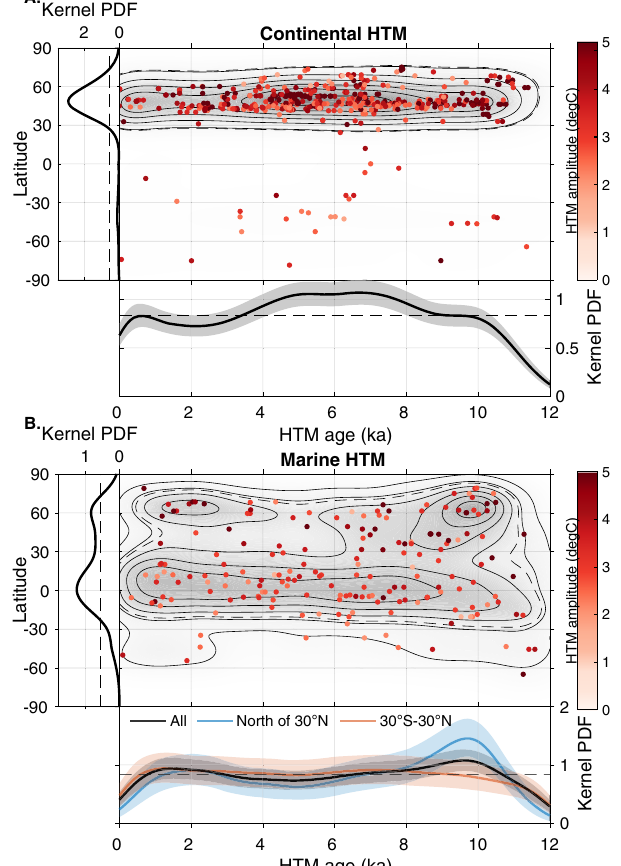
Fig. 1 | Spatiotemporal structure of the Holocene Thermal Maximum. Spatio- temporalstructureoftheHoloceneThermalMaximum(HTM)derivedfrommarine andcontinentaltemperaturerecords.DotsrepresentmedianHTMageandmedian HTM amplitude (anomaly compared to mean Holocene temperatures) calculated from the age and temperature ensembles for each continental ( A ) and marine record ( B ). Gray shadings and contours depict the mean of 10,000 kernel prob- ability density function maps (PDF; Gaussian kernel with a bandwidth of 10° in latitudeand500years)calculatedusingthetemperatureandagemodelensembles (see also Fig. 5 for contour label). Left and bottom panels correspond to median kernelprobabilitydensitycalculatedagainstlatitude(10°bandwidth)andage(500 years bandwidth), respectively for different subsets, with dashed straight lines corresponding to a homogenous distribution (color shading shows 10 – 90